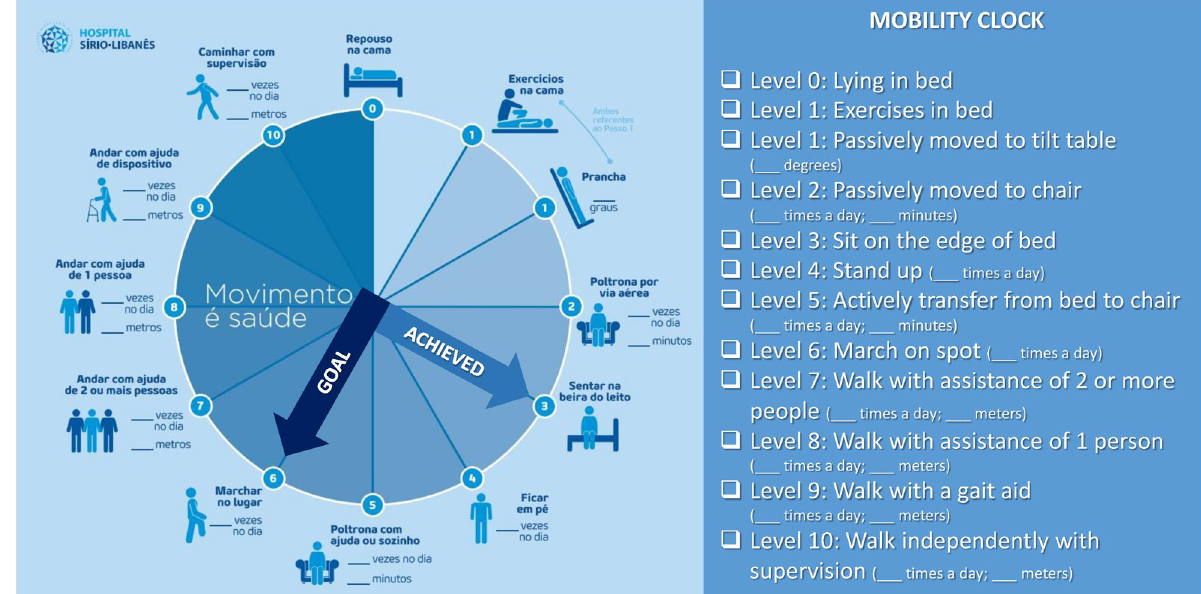
Figure 2. The mobility clock monitors the level of mobility in the intensive care units of Hospital Sírio-Libanês and is based on the ICU mobility scale. It presents ten mobility milestones (the higher the score, the higher the mobility level achieved by the patient). One of the hands of the clock represents the mobility level planned by the multidisciplinary team for the patient during the shift (goal), and the other, represents what was achieved. In the example above, the objective elaborated by the team was to “march on spot” (level 6) and the milestone achieved was to “sit on the edge of bed” (level 3). Thus, the objective was not reached because the level of mobility achieved was lower than